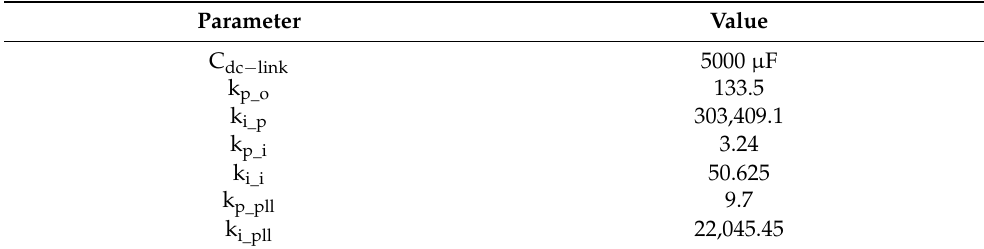
Table 6. Inverter control parameters